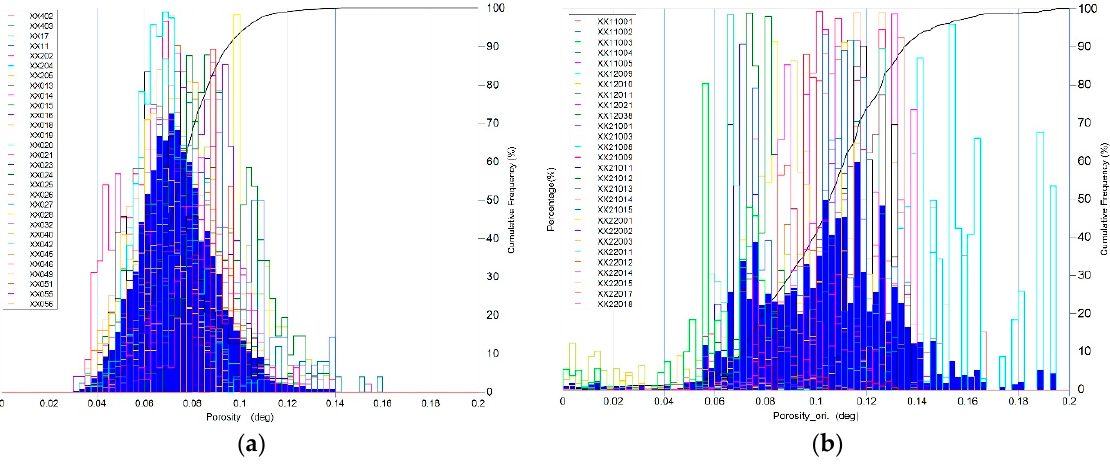
Figure 2. The distribution of the clay content obtained from conventional logging interpretations.